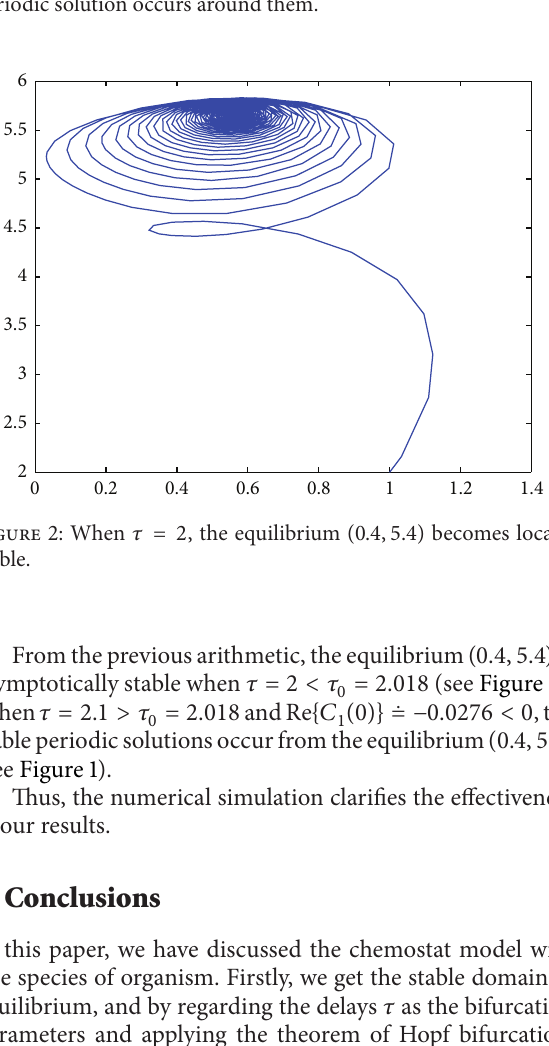
Figure 1: When 𝜏 = 2.1 , the equilibrium (0.4,5.4) is unstable and periodic solution occurs around them.